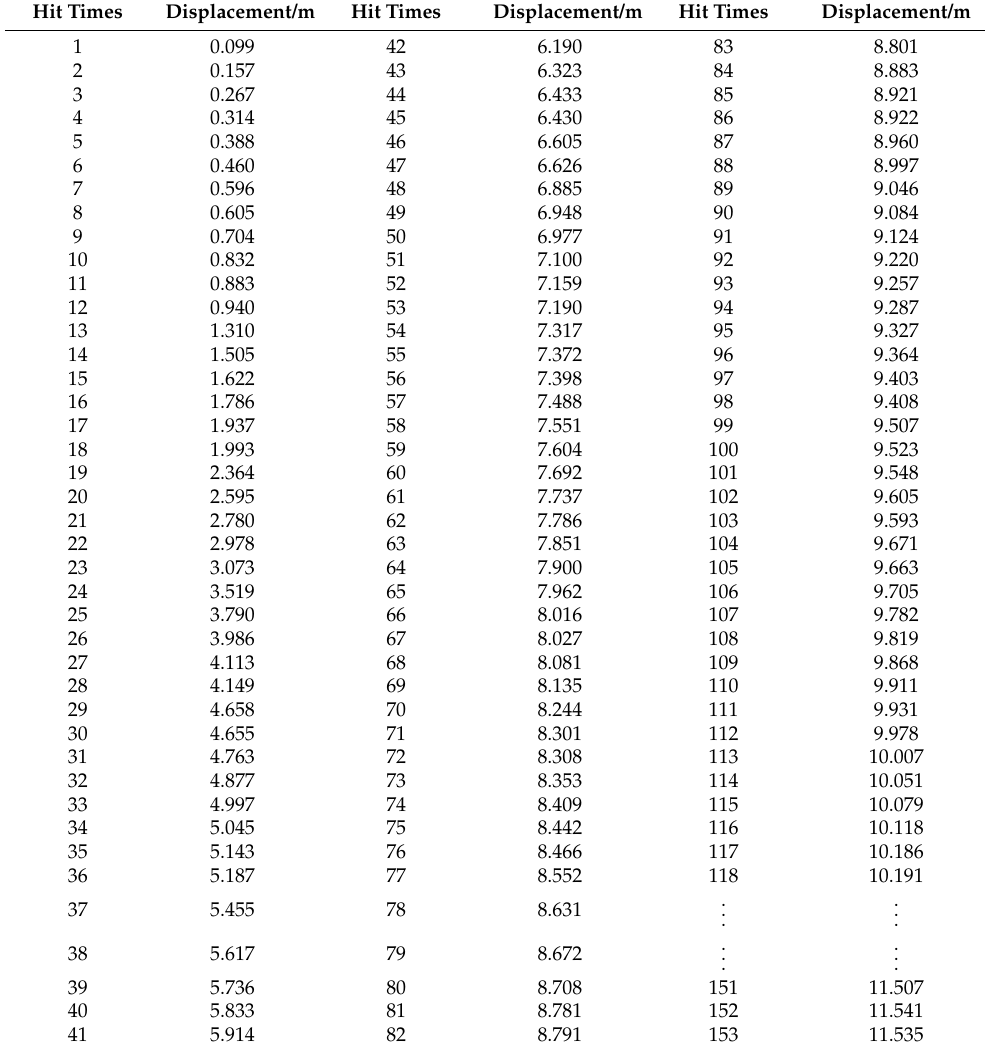
Table 4. Monitoring data of pipe pile penetration at No. 6 pile